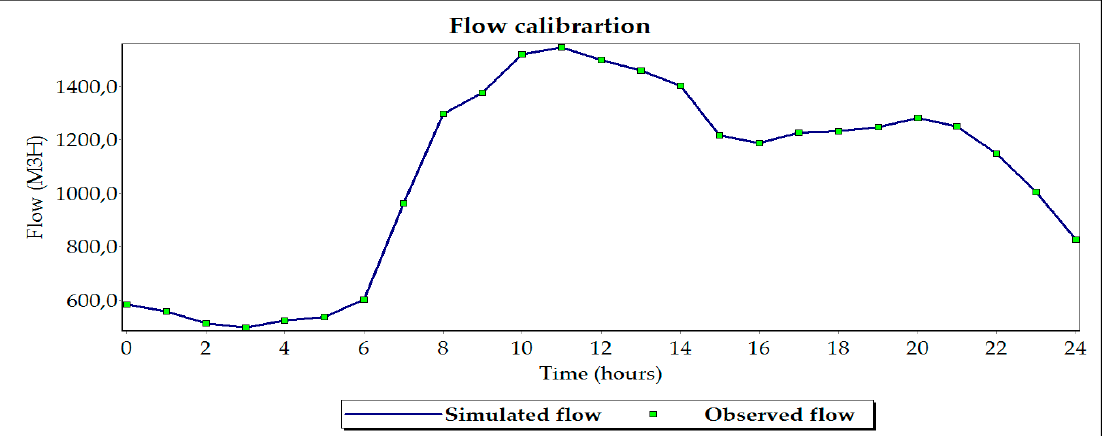
Figure 3. Flow calibration in EPANET.